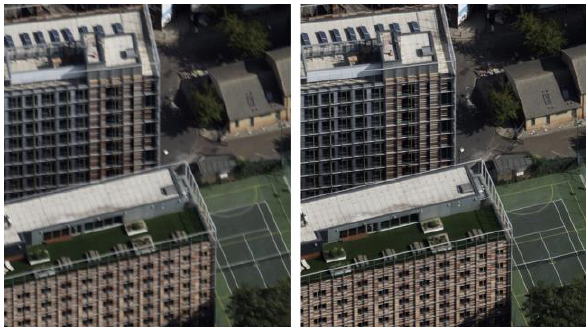
Figure 6 : Details of building facades within a large-scale oblique image (UltraCam Osprey 4.1, GSD nadir 3,5 cm). Strong angular motion blur exists (cf. left image) and was successfully compensated by AMC (cf. right